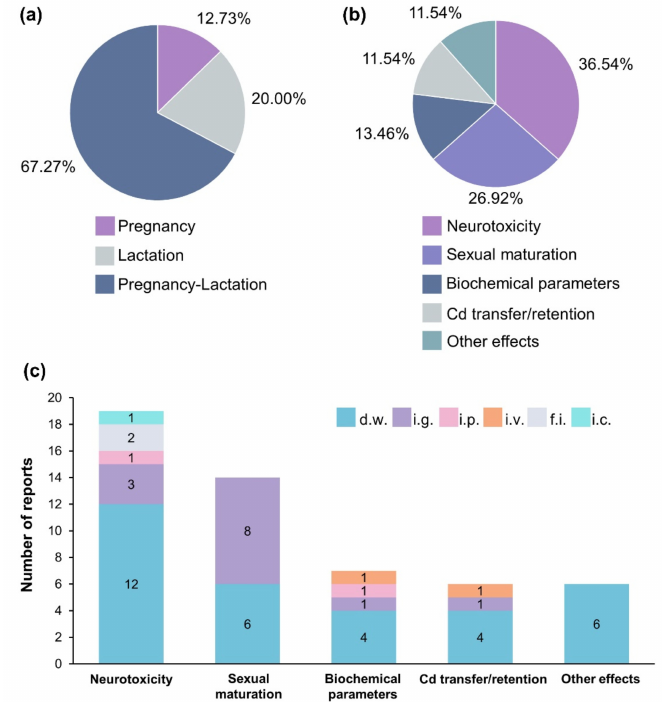
Figure 4. Cd exposure scheme, effects evaluated and administration routes. ( a ) Percentage of works reporting pregnancy, lactation, or pregnancy–lactation exposure. ( b ) Percentage of reports evaluating different Cd effects. ( c ) Number of reports that described each Cd administration